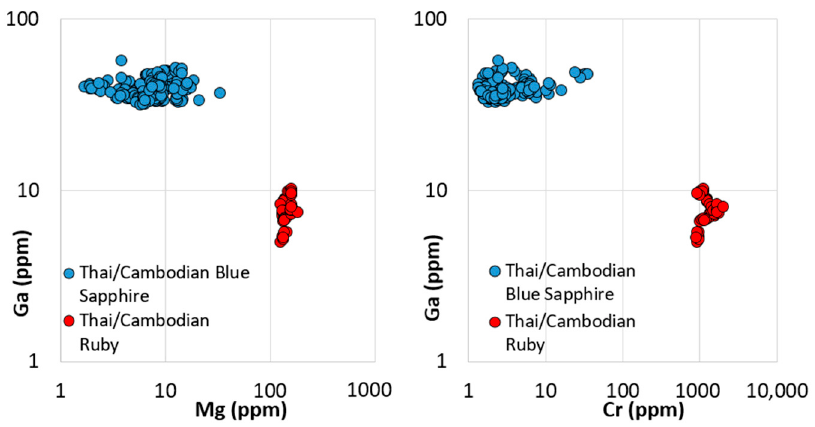
Figure 1. Trace element plots of Thai / Cambodian rubies and sapphires including Mg vs. Ga ( left ) and Cr vs. Ga ( right ) plots.